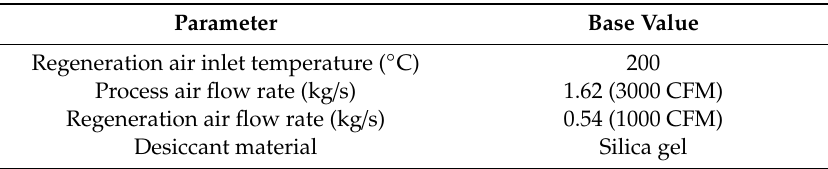
Table 2. Operating